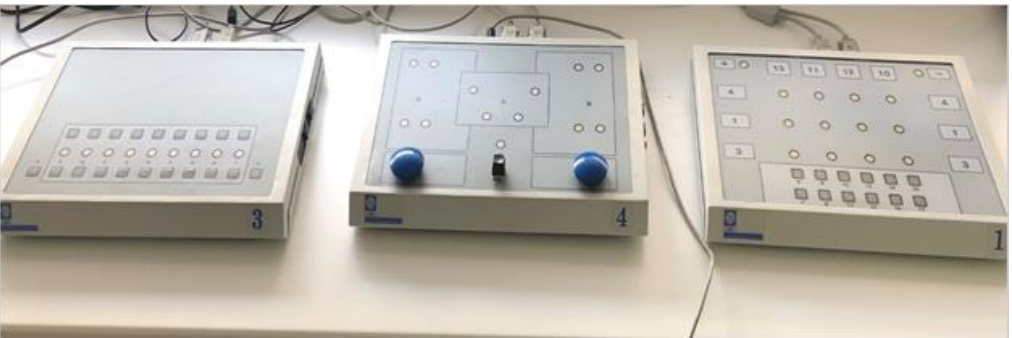
Figure 1. Complex Reactionmeter Drenovac (CRD)-series. In this research, test CRD311 assessing discrimination of simple visual stimulus was solved on the left panel marked with number 3, test CRD411 assessing complex psychomotor coordination was solved on the middle panel marked with number 4, and test CRD11 assessing convergent thinking through solving simple mathematical operations was solved on the right panel marked with number 1. The light stimulus in all tests was presented in small circles on each panel.